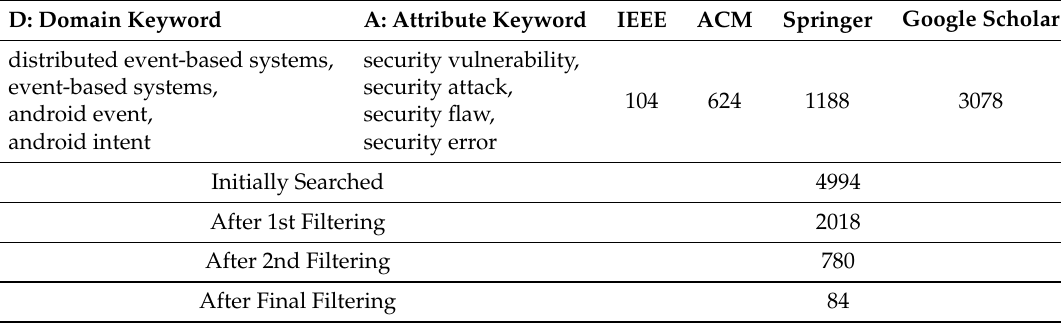
Table 2. Number of Collected References during Literature Review